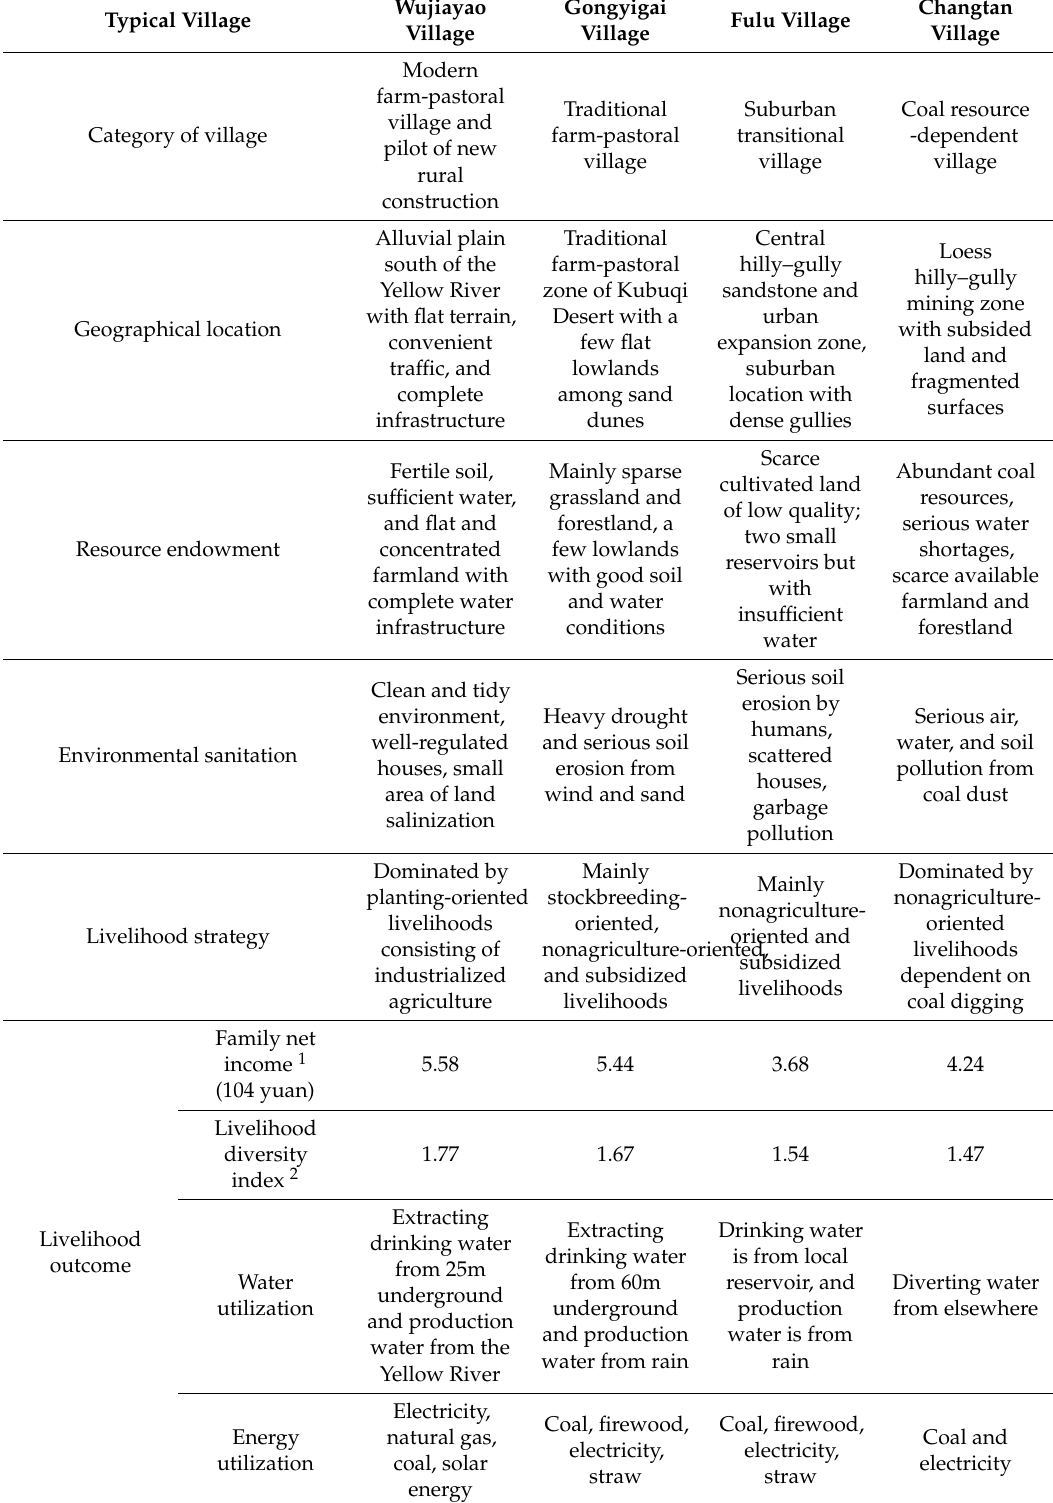
Table 2. Rural livelihoods and the environment in the four typical